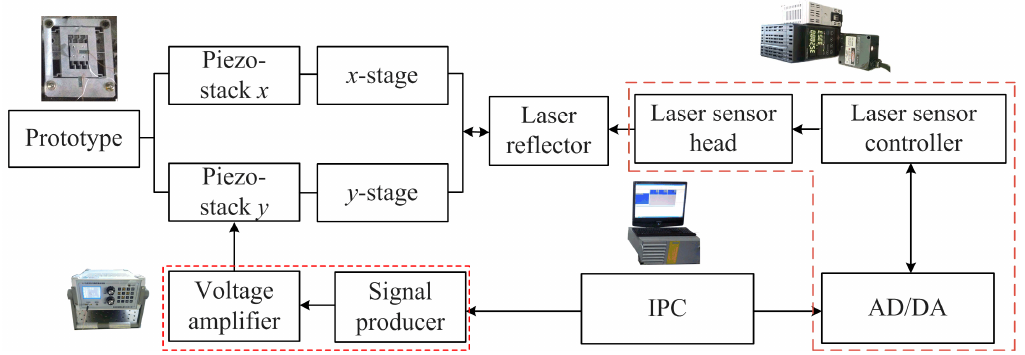
Figure 7. Experimental system for the proposed 2-DOF piezoelectric-driven platform.